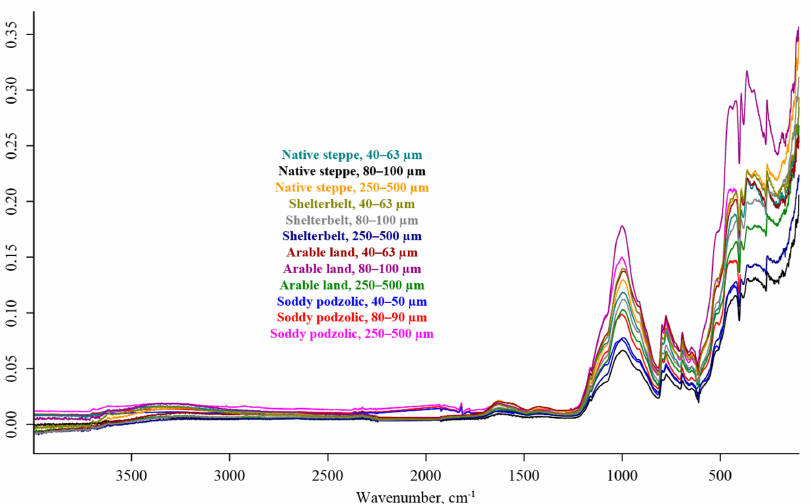
Figure 2. ATR–FTIR spectra of fractions of chernozem and sod-podzolic soils. Chernozem na- tive steppe, 40–63 µ m, dark cyan; 80–100 µ m, black; 250–500 µ m, orange; chernozem shelterbelt, 40–63 µ m, khaki; 80–100 µ m, gray; 250–500 µ m, dark blue; chernozem arable land, 40–63 µ m, dark red; 80–100 µ m, dark magenta; 250–500 µ m, dark green; sod-podzolic, 40–50 µ m, blue; 80–90 µ m, red; 250–500 µ m, light